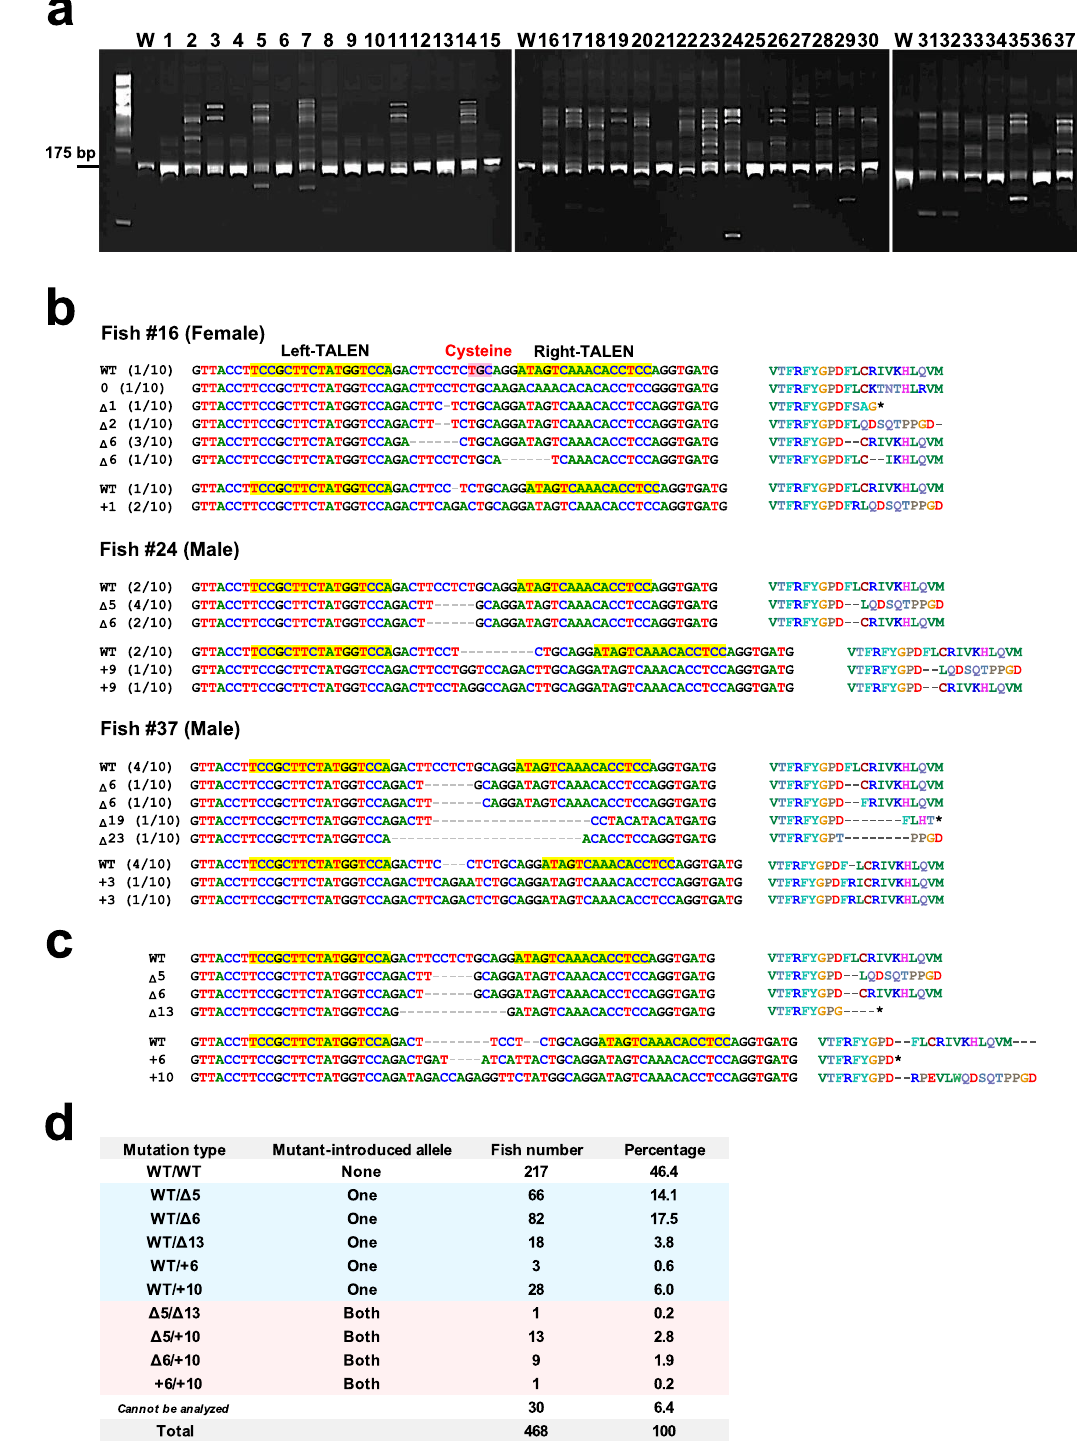
Figure 3. Production of the V1a2 knockout lineage. ( a ) Results of the heteroduplex mobility assay (HMA) analysis of all V1a2 KO F 0 generation that survived 5 months of age. W indicates wild type. NC indicates negative control. ( b ) The gene sequence and amino acid sequence of the target site of the F 0 generation, which had a particularly high mutagenesis rate and was selected for F 1 generation production (one female and two males). The label number (#) of the individual matches the number of HMA analysis result in ( a ). Alignment results of the data obtained by sequence analysis of 10 clones of each fish are shown. The left and right TALEN recognition areas are highlighted in yellow. Δ indicates a base deletion, and plus indicates a base insertion. *indicates a stop codon. ( c ) As a result of sequence analysis of the target gene sites of all F 1 fish that survived 5–6 months post-hatch, three patterns of defective mutation and two patterns of base insertion were confirmed. ( d ) Breakdown of mutants of both alleles in all F 1 fish sequenced. In 30 individuals, the genotype is still unknown, since clear sequence analysis results were not